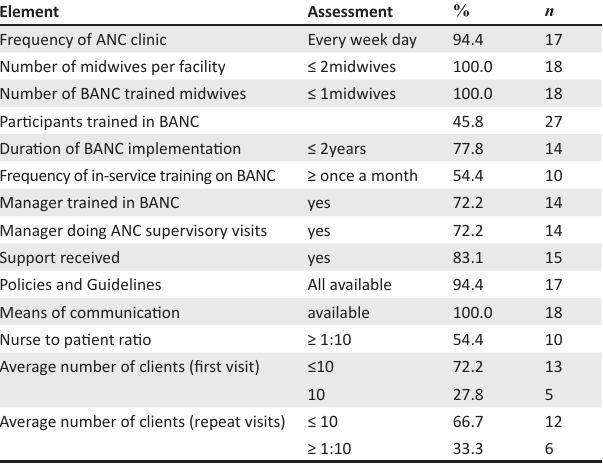
TABLE 2: Responses from the